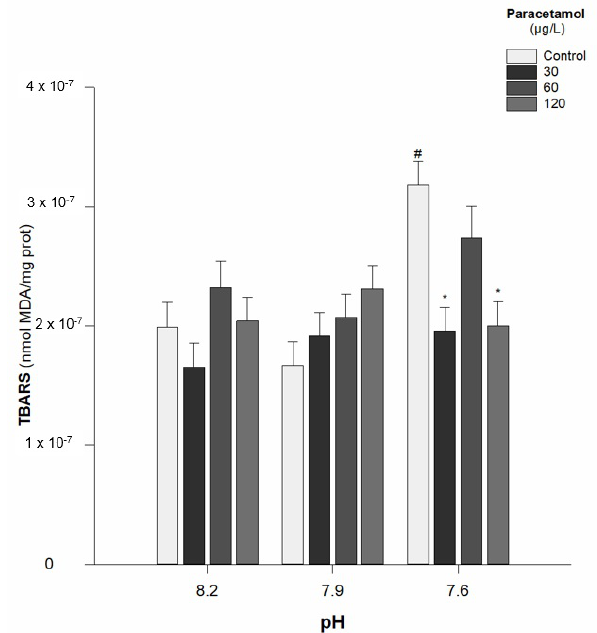
Figure 3. Thiobarbituric acid reactive substance (TBARS) content in Hediste diversicolor exposed to paracetamol (0, 30, 60, and 120 µg/L) under the pH values of 8.2, 7.9, and 7.6. Values are the mean ± standard errors. Statistical differences among PAR concentrations (30, 60, and 120 µg/L) and the control group (0 µg/L) are represented with “*”. Statistical differences between pH treatments (7.9 and 7.6) and the pH control group (8.2) within each PAR concentration are represented with “#”. Statistics refer to Dunnett’s tests (following a Two-Way ANOVA). Values are mean ± standard